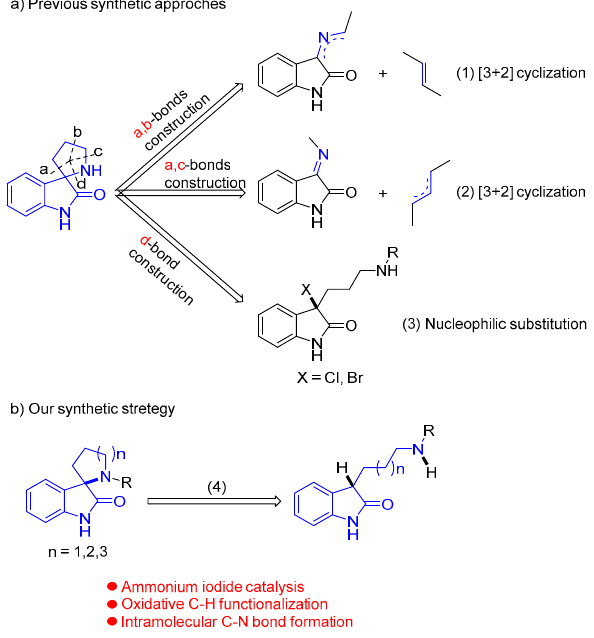
Scheme 1. Strategies for the 3,2 ′ -pyrrolidinyl spirooxindole